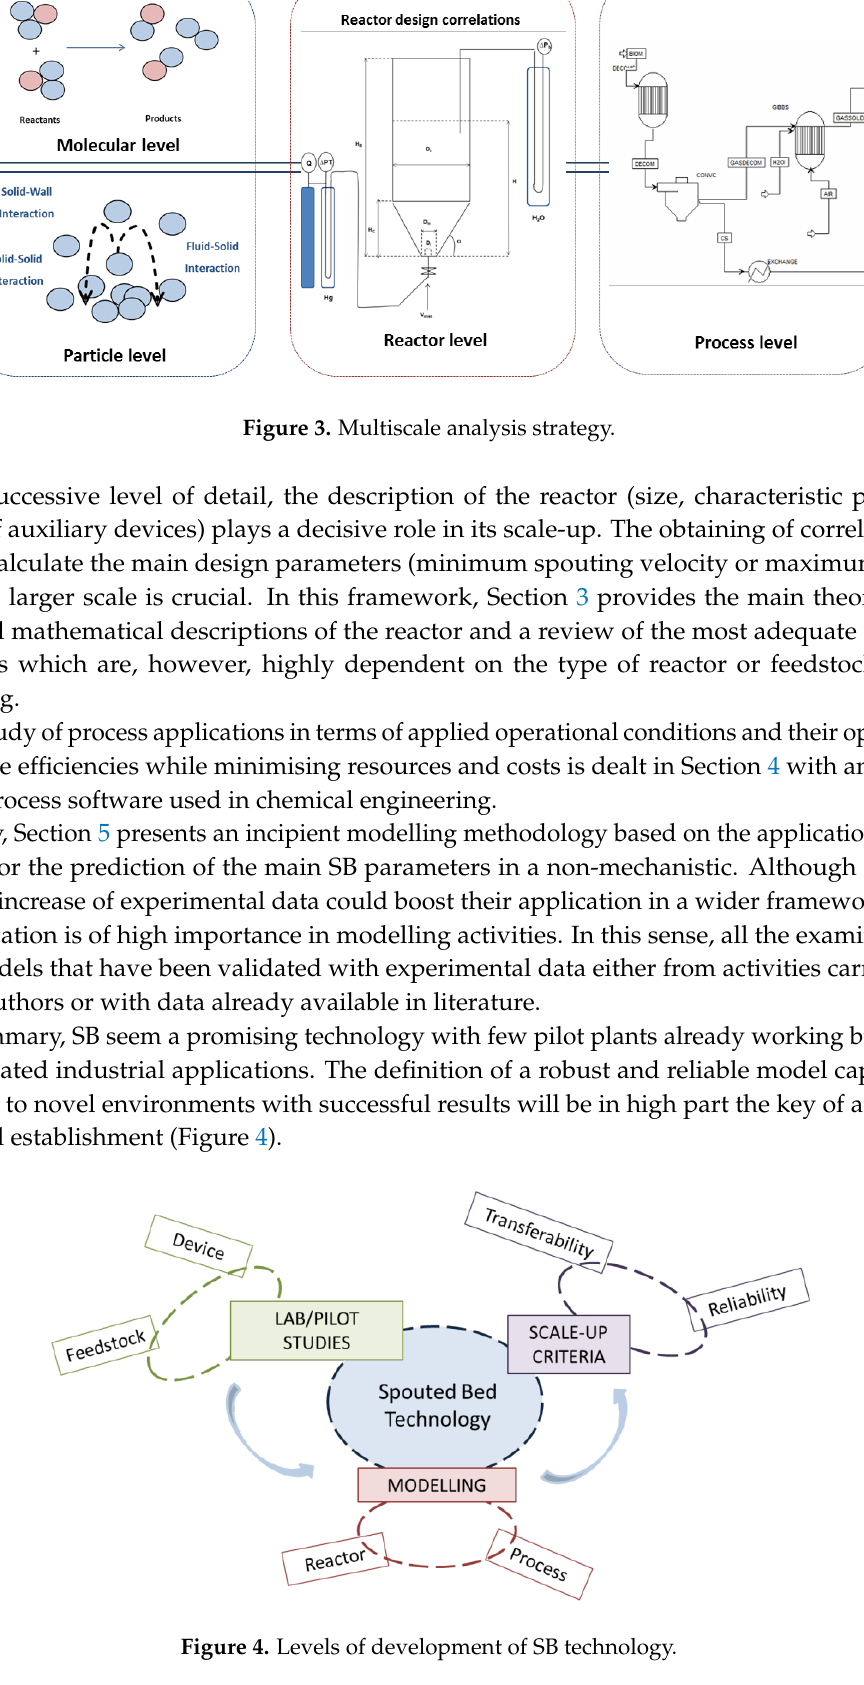
Figure 4. Levels of development of SB technology.